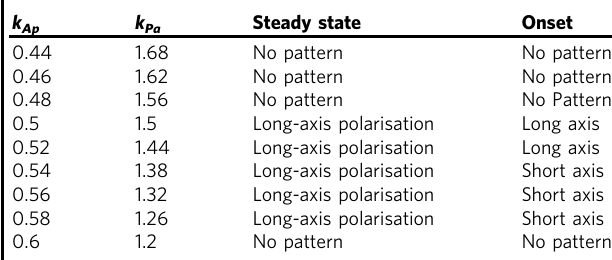
Table 3 FEM sample sweeps of k Ap , k Pa with small